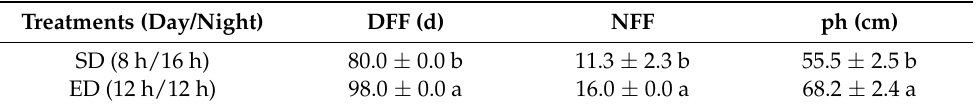
Table 2. The detailed information of XIS cucumber, SWCC8, when the first flower opens under two photoperiod